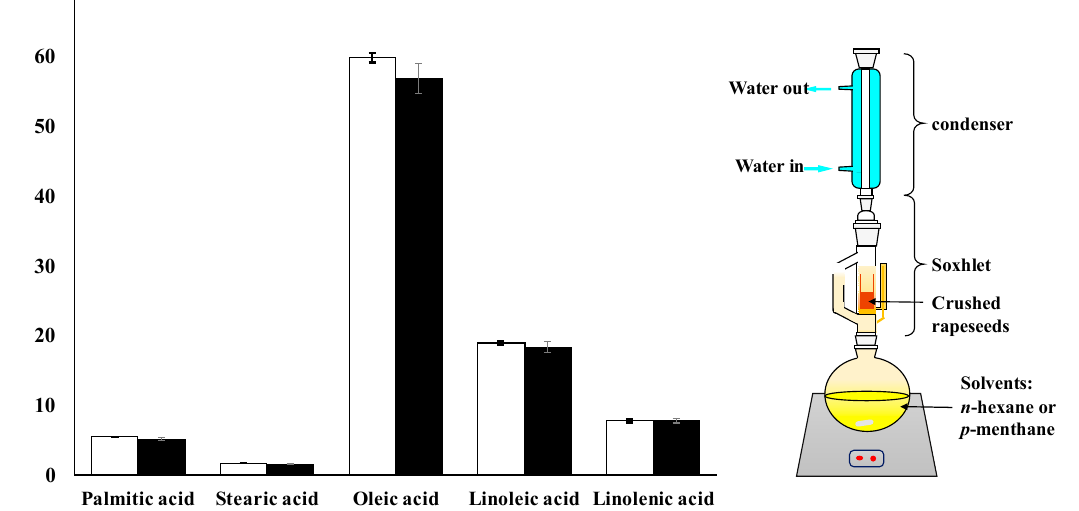
(cid:4) ) and n -hexane ( (cid:3) ).